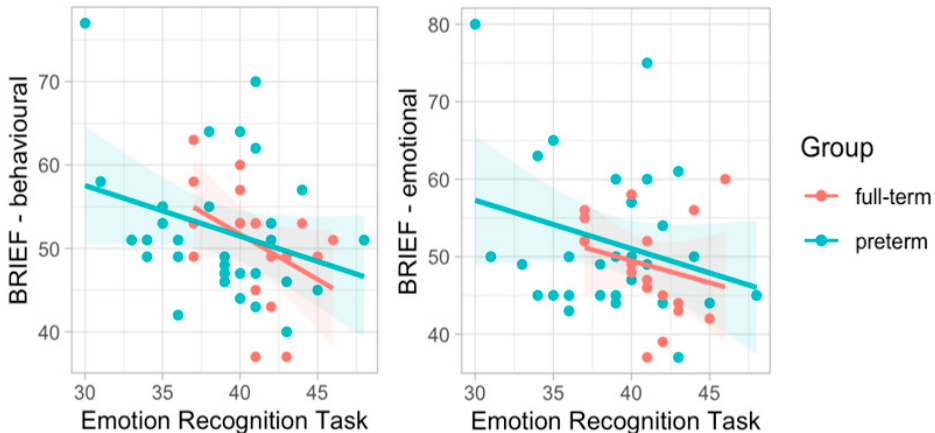
Figure 7. Correlations between ERT and subscales of behavioral and emotional functioning from